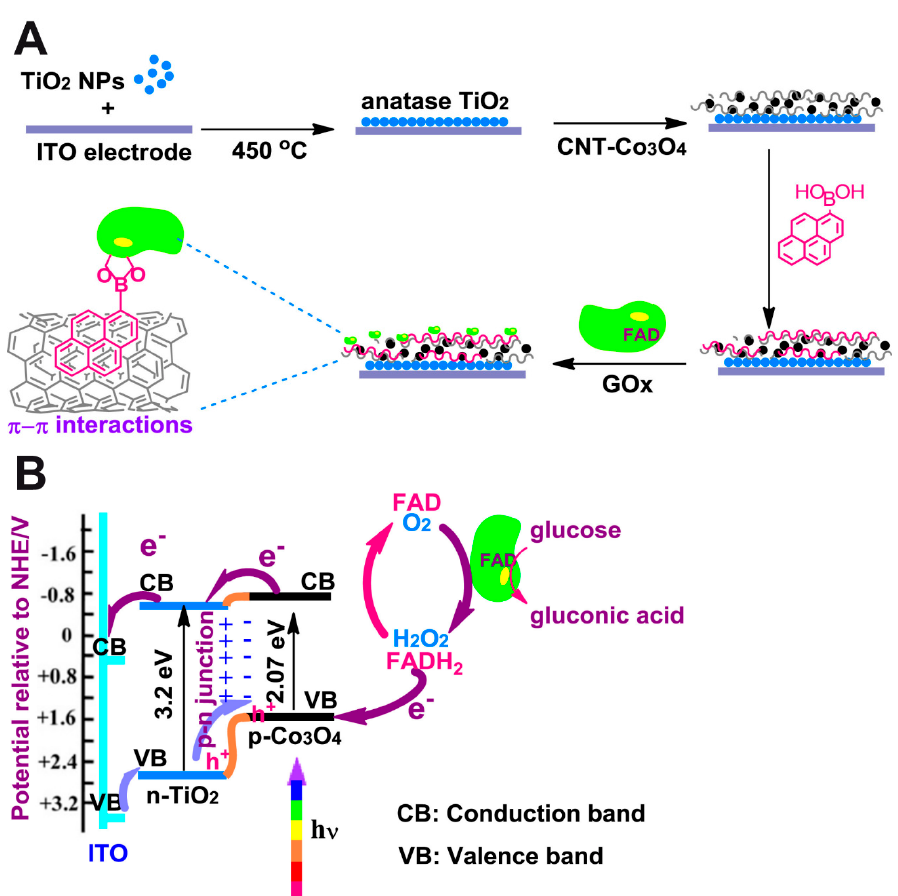
Figure 2. ( A ) Schematics of the photo-biosensor synthesized step by step. ( B ) Energy transfer diagram for the work showing the valence bands and conduction bands of the photo-biosensor components. Taken with permission from ref. [49].